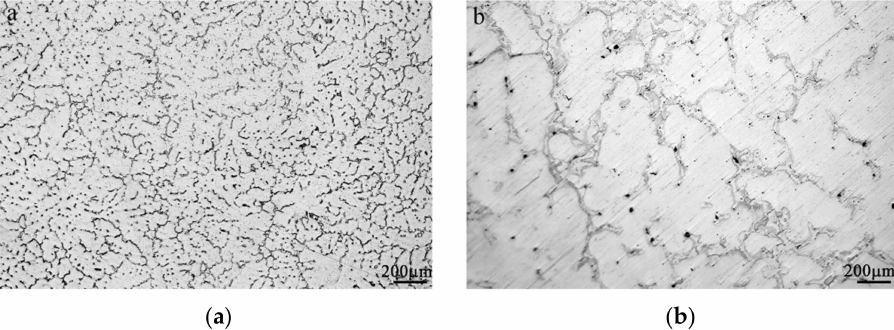
Figure 3. Optical images of the ( a ) as-cast and ( b ) as-homogenized ZM51